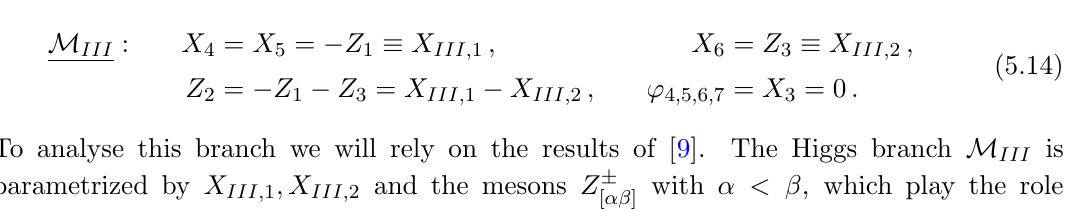
Figure 27 . Setups realizing the insertion of the branch II operators: (a) X II , (b) v + setup revealing the relation v + shown. The vertical direction is that spanned by the 5